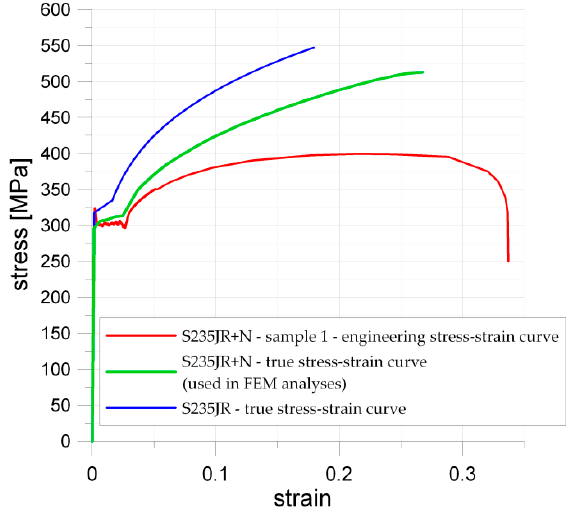
Figure 21. Engineering and true stress–strain curves for S235JR and S235JR + N steels.